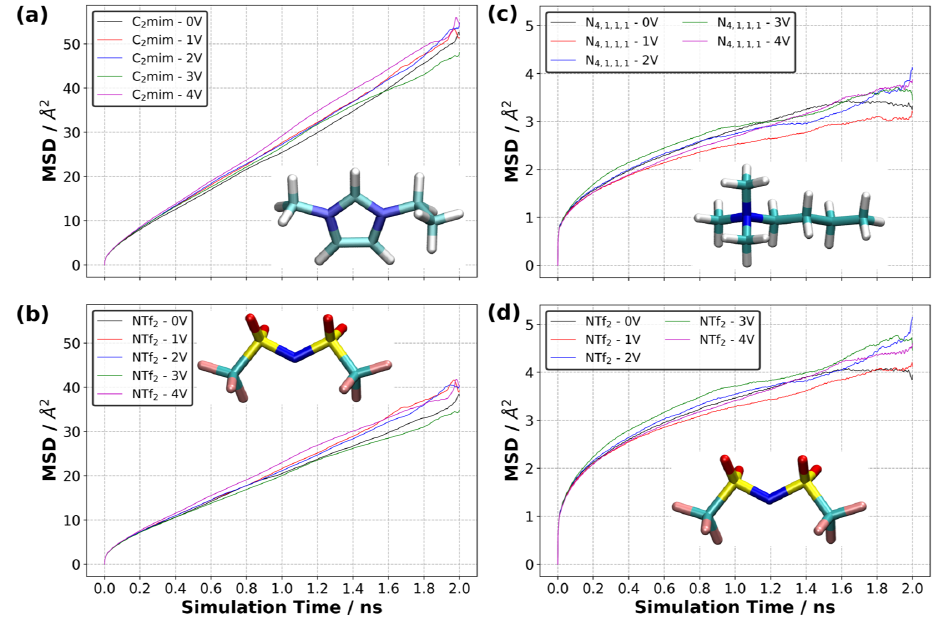
Figure 16. Calculated mean square displacement (MSD) at various potential difference at 294 K for ( a ) [C 2 mim] + and ( b ) [NTf 2 ] − in [C 2 mim][NTf 2 ] system, ( c ) [N 4,1,1,1 ] + and ( d ) [NTf 2 ] − in [N 4,1,1,1 ][NTf 2 ] system (averaged over three independently generated